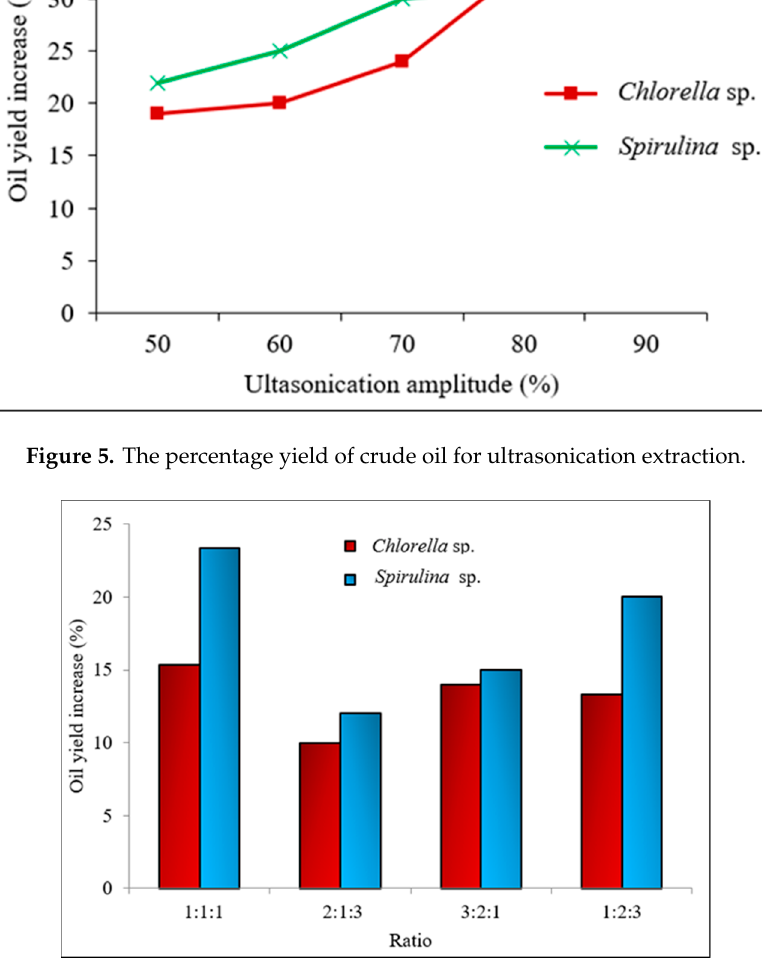
Figure 6. The percentage yield of microalgae by Soxhlet extraction with a solvent system of chloroform, hexane, and methanol (C:H:M) with different ratios.